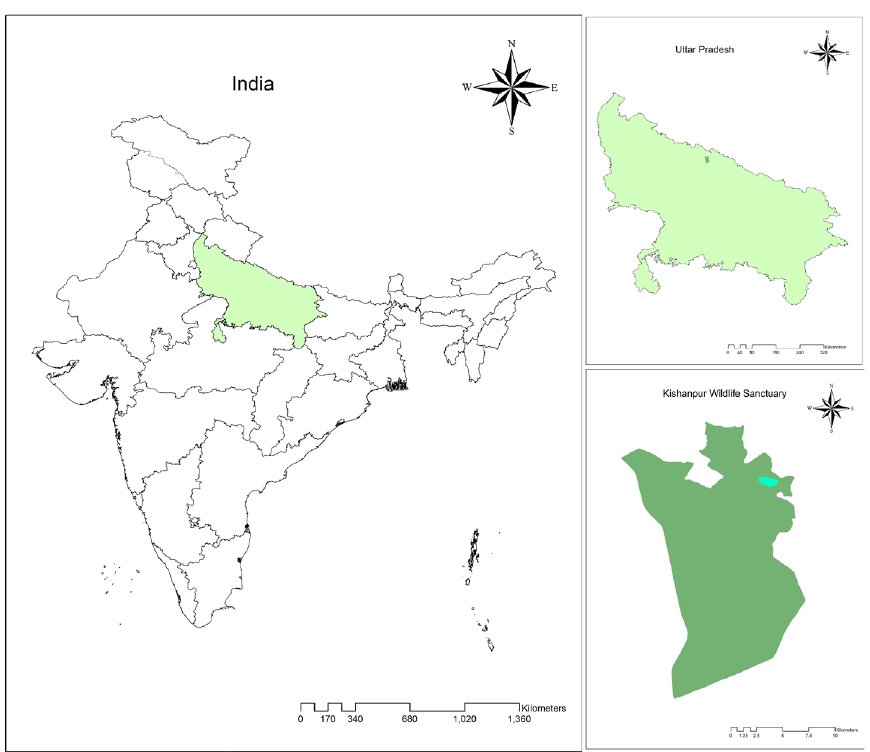
Figure 2. Map showing the location of Kishanpur Wildlife Sanctuary in Uttar